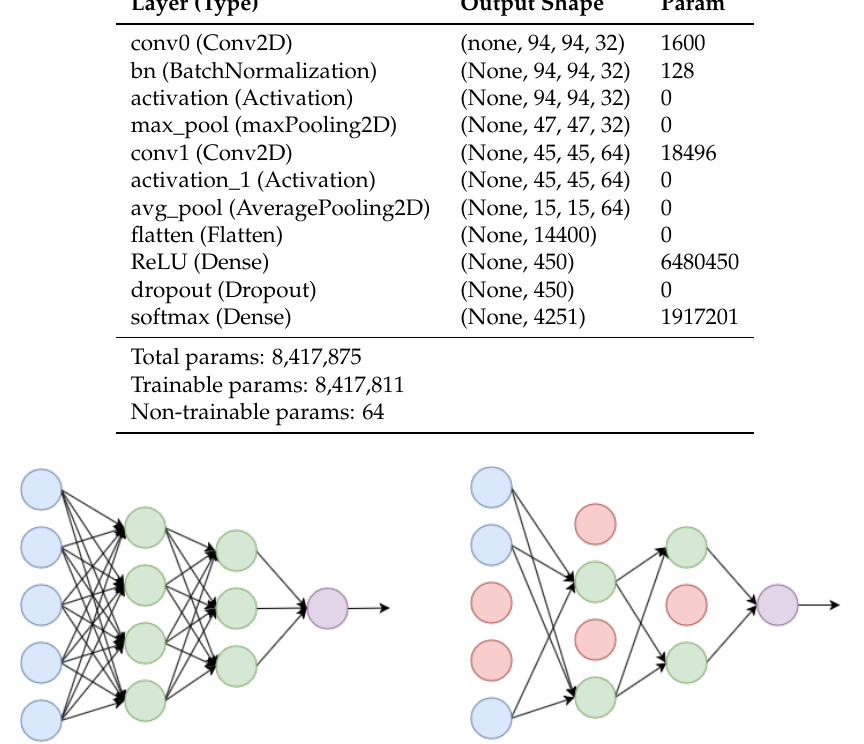
Figure 11. Dropout schema used in convolutional neural networks (Input layer in blue, hidden layers in green, output layer in purple and dropout neurons in